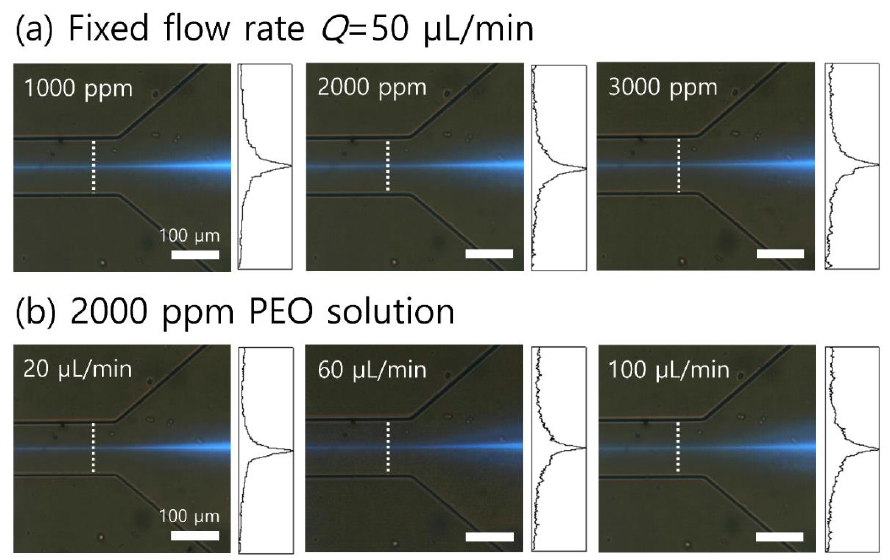
Figure 2. Evaluation of ( a ) the effect of the polymer concentration (1000, 2000, and 3000 ppm) at the fixed flow rate of 50 μL/min and ( b ) the effect of the flow rate (20, 60, and 100 μL/min) in the 2000-ppm PEO solution on flow characteristics of 2- µ m fluorescent polystyrene particles. White dotted lines show the position of fluorescent intensity measurement. The X and Y axes indicate the normalized fluorescence intensity of 0–1 and channel width of 0–100 µ m, respectively.